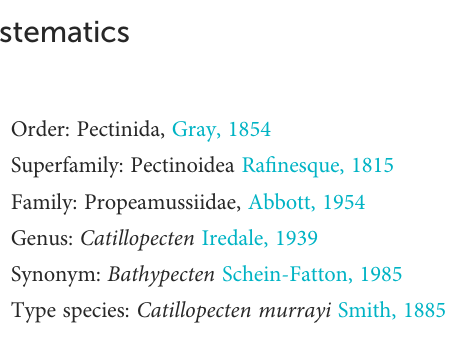
(Figure 1), collected using the suction sampler of the ROV Pioneer , September 2022, ROV02, Dive